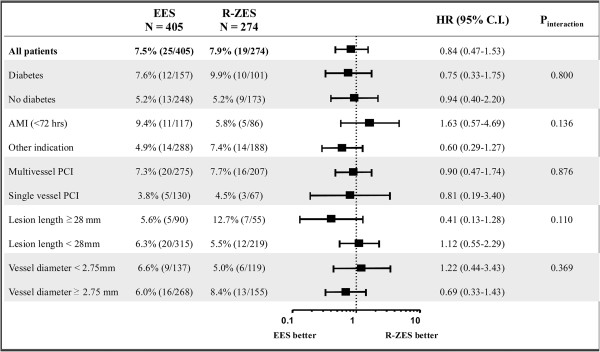
Subgroup analysis. Abbreviations: EES, everolimus-eluting stent; R-ZES, Resolute zotarolimus eluting-stent; HR, hazard ratio; CI, confidence interval; AMI, acute myocardial infarction; PCI, percutaneous coronary intervention.